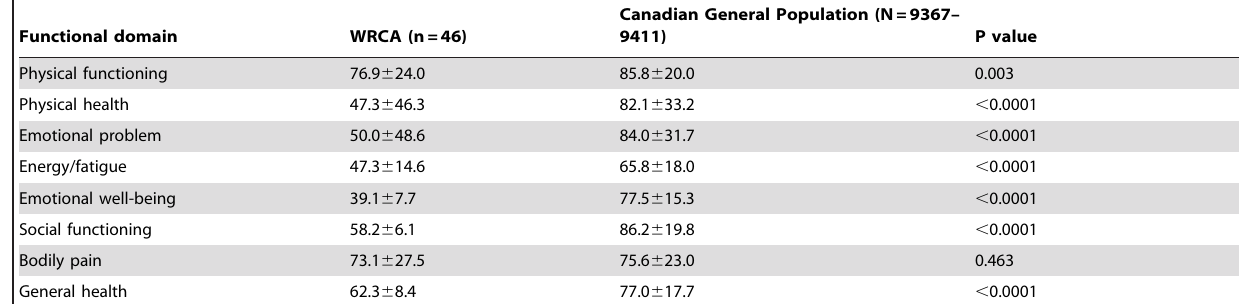
Table 3. Health-related quality of life scores.*